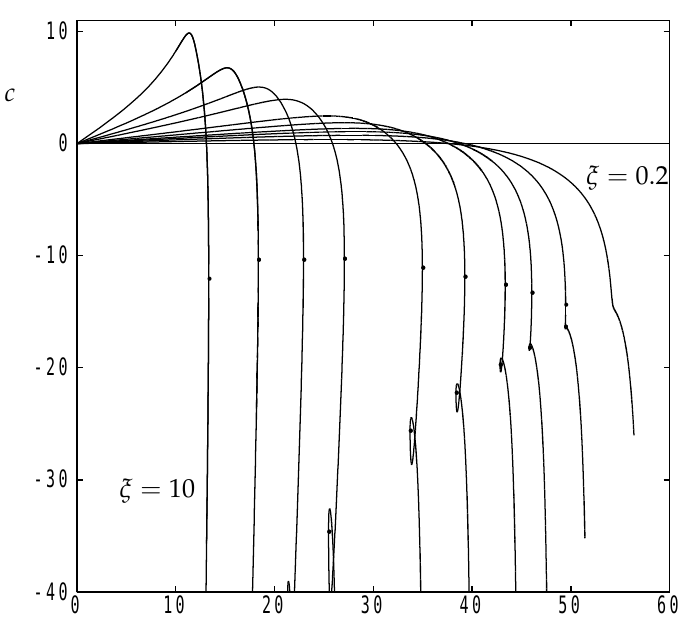
Figure 5. Showing the variation of c , the phase velocity of transverse roll disturbances, at critical points on the neutral curve for ξ = 0.2 0.3, 0.4, 0.5, 0.7, 1, 2, 3, 5 and 10. The black disks correspond either to isola points or to saddle points.